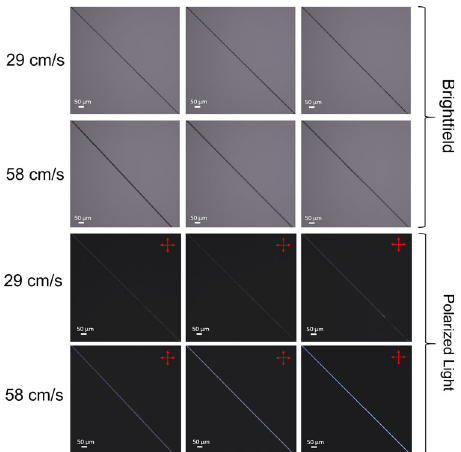
Fig. 7 Representative bright fi eld and polarized light microscopy images of NT2RepCT fi bers. Three different fi bers obtained at a reeling speed of 29 and 58 cm/s are shown. The red double arrows represent the direction of the polarizers. Representative SEM images of these fi bers and fi bers obtained in different conditions are shown in Supplementary Figs. 16 and